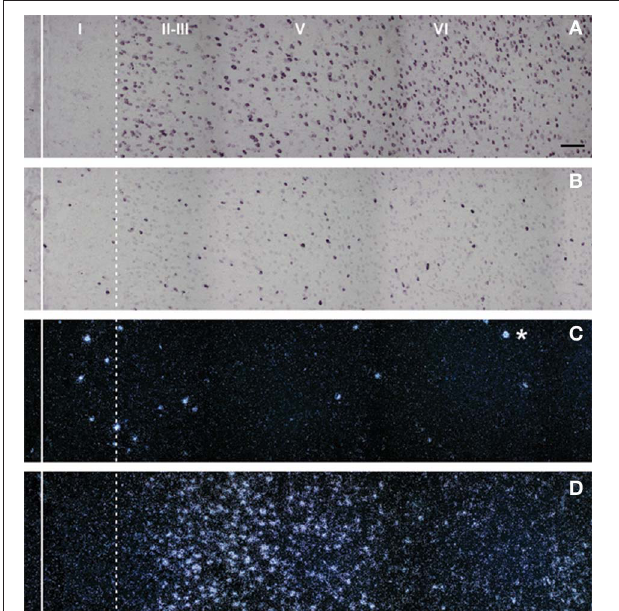
FIGURE 2 | Composite photomicrographs showing the localization of cells expressing vGluT1 (A), GAD (B), 5-HT 3 (C), and 5-HT 2A (D) mRNAs through layers I–VI at the level of the prelimbic area in the rat PFC. The continuous vertical line denotes the location of the midline whereas the dotted line shows the approximate border between layer I and II. Pyramidal neurons (as visualized by vGluT1 mRNA) are present in layers II–VI whereas GAD mRNA-positive cells are present in all layers, including layer I. Note the segregation of cells expressing 5-HT 3 (C) and 5-HT 2A receptors (D) . 5-HT 3 receptor transcript is expressed by a limited number of cells present in layers I–III, particularly in the border between layers I and II. However, they represent 40% of GABAergic neurons in layer I. On the other hand, cells in these locations, particularly in layer I, do not express 5-HT 2A receptors. The asterisk denotes an artifact of the emulsion, seen in the dark field. Scale bar = 150 μ m. Reproduced with permission from Puig et al.